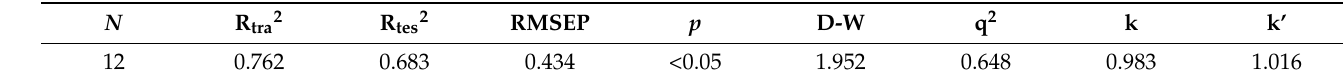
Table 2. The description and statistical information of the predictive model.